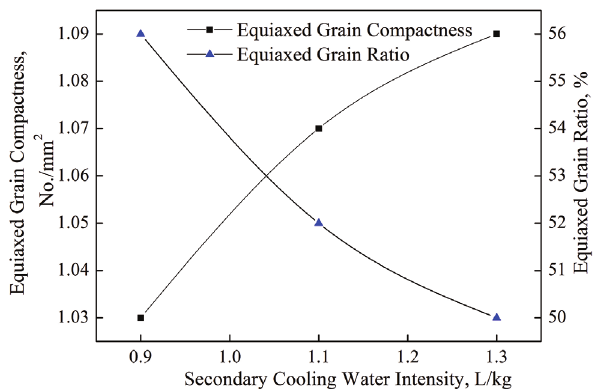
Fig. 7: The calculated equiaxed grain compactness and equiaxed grain ratio of 82B steel under different secondary cooling water